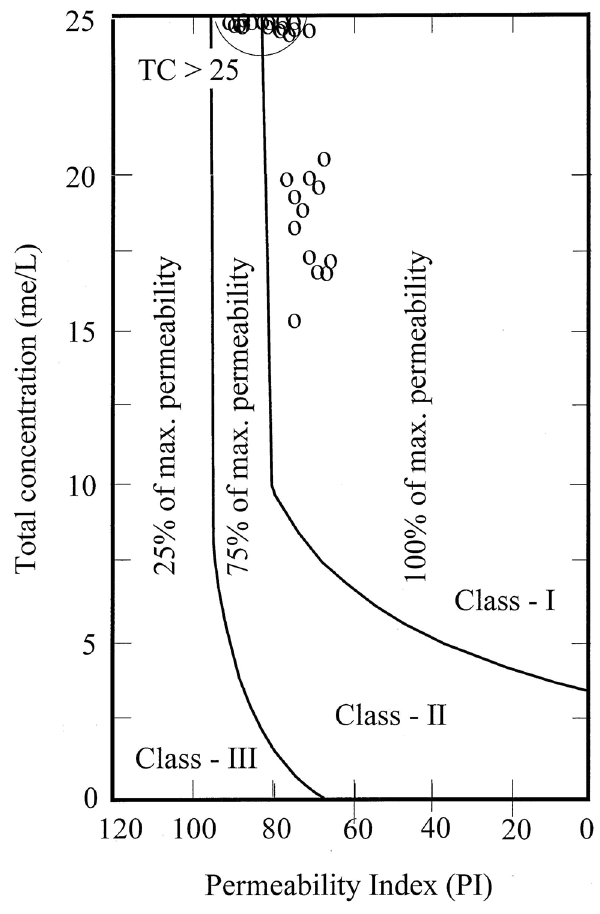
Fig. 9 Groundwater quality for irrigation (after Doneen 1964)